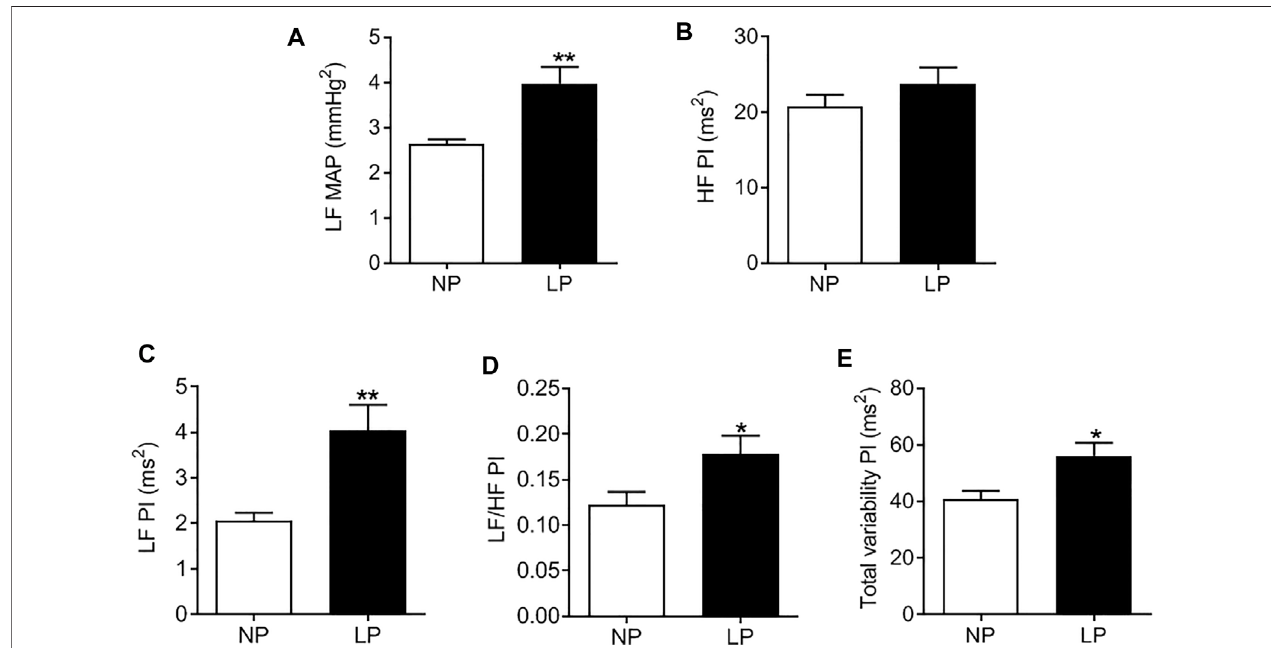
FIGURE3| Spectralanalysisofarterialpressureandpulseintervalin120-day-oldanimalsatbaselineconditions.Lowfrequencyzoneofmeanarterialpressure (A) , highfrequencyzoneofpulseinterval (B) ,lowfrequencyzoneofpulseinterval (C) ,lowfrequency/highfrequencypulseinterval (D) ratio,totalvariabilityofthepulseinterval (E), n = 7 – 9 animals per group. NP, normal protein diet; LP, low protein diet. Values presented as mean ± SD *** p < 0.001, ** p < 0.01, and * p < 0.05 indicate statistical signi fi cance (Student ’ s T test).